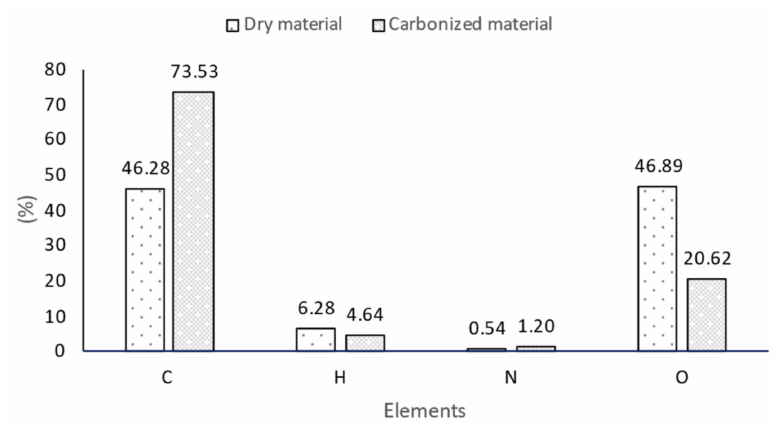
Figure 4. Evolution of CHNO contents after carbonization of vine